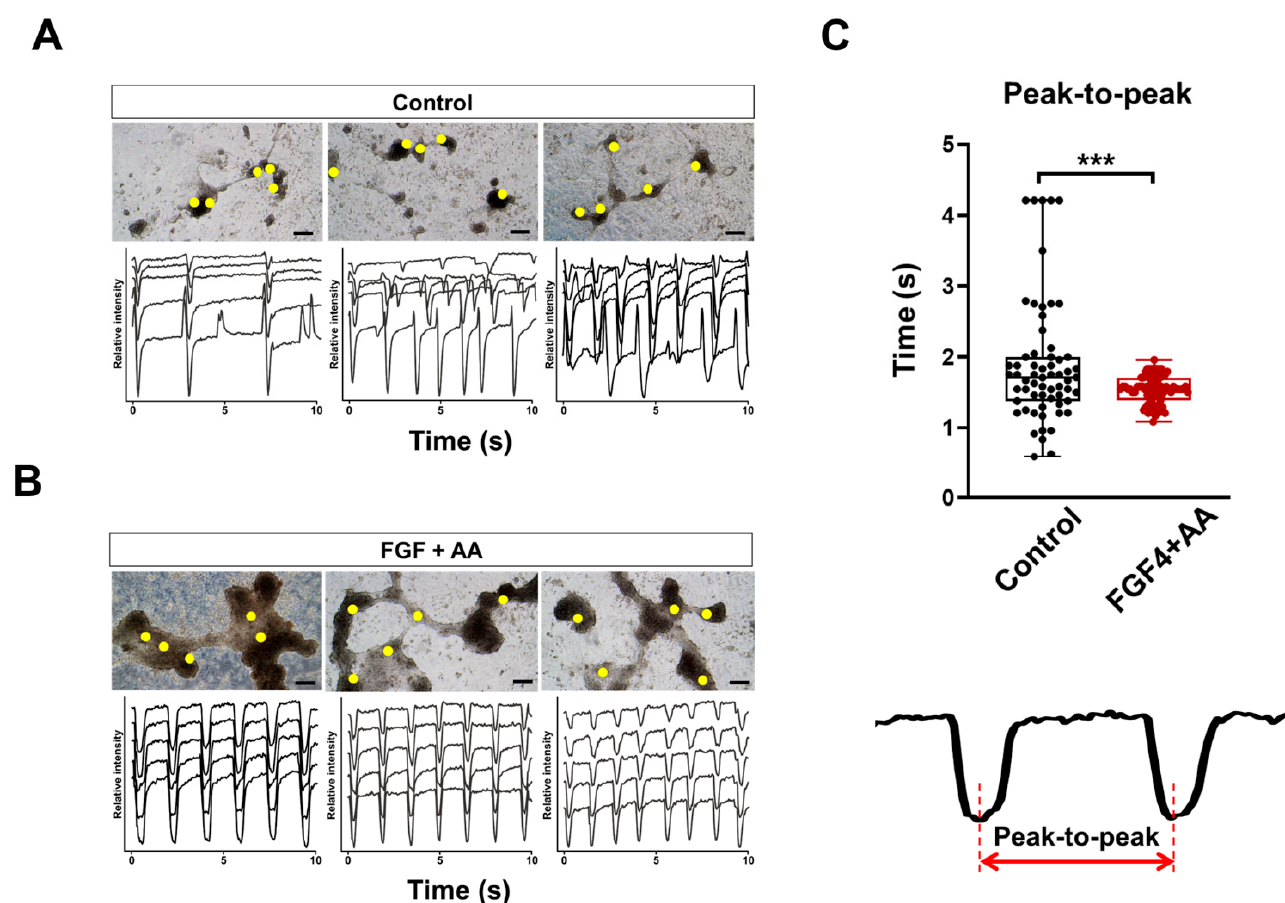
Figure 2. Co-treatment of FGF4+AA synchronize contraction of BG01 hESC-CMs. Beating characteristics at day 15 in ( A ) untreated CMs and ( B ) 10 ng/mL FGF4 + 200 µ g/mL AA-treated CMs were assessed by monitoring the light intensity of the selected regions (yellow circles) of interest over a 10 s period. Scale bars = 100 µ m. ( C ) Comparison of peak-to-peak durations. *** p < 0.001 (n = 63 for control and 80 for FGF4+AA; two-tailed unpaired Student’s t -test).